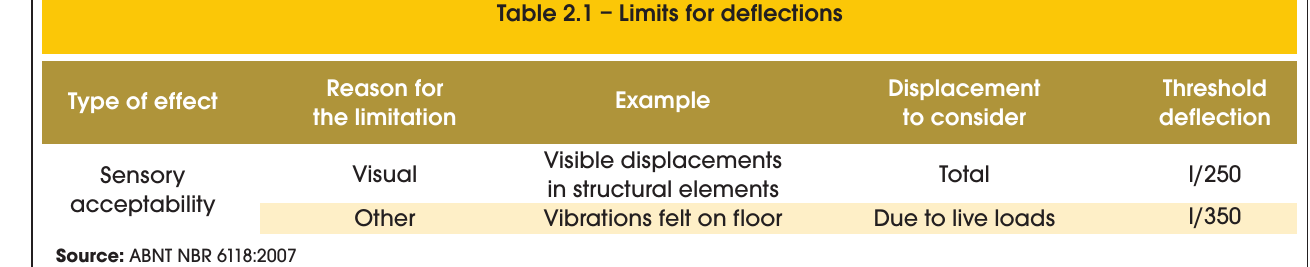
Table 2.1 – Limits for deflections